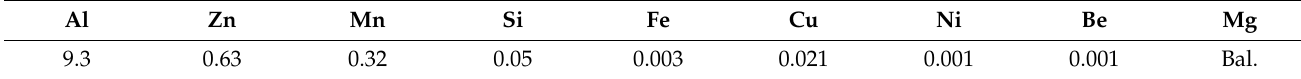
Table 1. Chemical composition (wt.%) of AZ91 magnesium alloy.